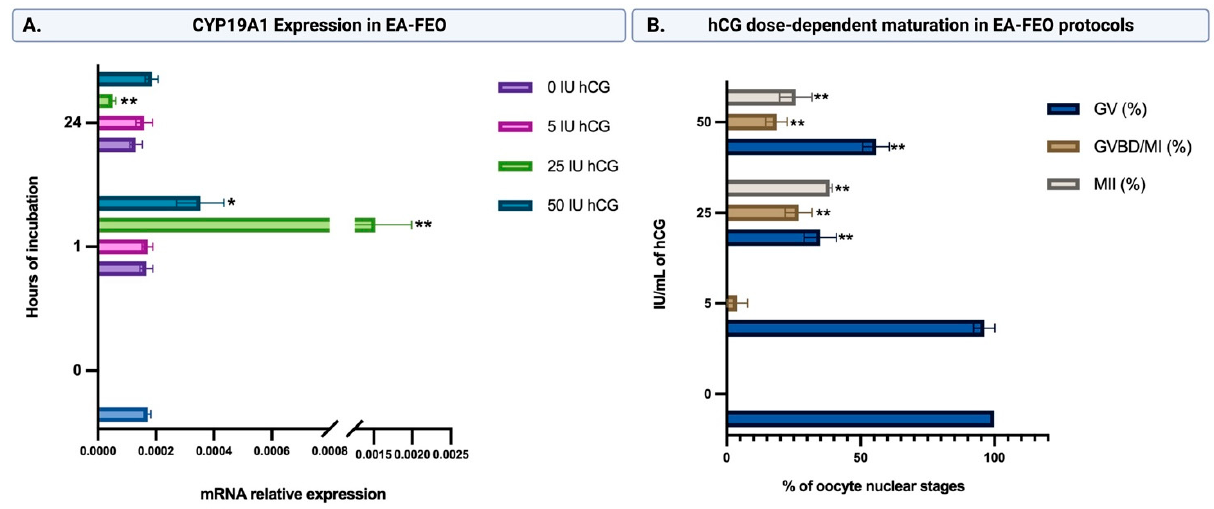
Figure 4. ( A ) Influence of hCG stimulation of FEO on the expression of steroidogenic-specific gene CYP19A1. The maturation protocols were optimized for hCG stimulation by carrying out the EA- FEO incubation on PCL scaffolds for 24 h and exposing them to increasing doses of hCG (5, 25, 50 IU/mL) or without any hormonal stimulation (Ctr). The responsiveness of FEO to hCG was functionally tested by comparing the CYP19A1 gene expression before (time 0, Ctr) and after hCG stimulation (at 1 and 24 h). Three independent biological replicates were performed. Ten follicular walls per group were processed for gene expression analysis. mRNA data were statistically analyzed vs. Ctr (Time 0) and indicated with (*) or (**) when significantly different for p < 0.05 or p < 0.01, respectively. ( B ) hCG influence of FEO meiotic resumption. The induction of maturation promoted by different doses of hCG (0, 5, 25, 50 IU/mL) was tested in EA-FEO after 24 h of incubation by analyzing the oocyte nuclear stages. Three independent biological replicates were performed for each experimental group (total number of oocytes analyzed: 126, 132, 127, and 133, respectively, for time 0, 5, 25, and 50 IU/mL). The significance of each nuclear stage data (GV, GVBD/MI, or MII) was statistically analyzed vs. Ctr (0 IU hCG) and indicated with (*) or (**) superscripts when p < 0.05 or p < 0.01,